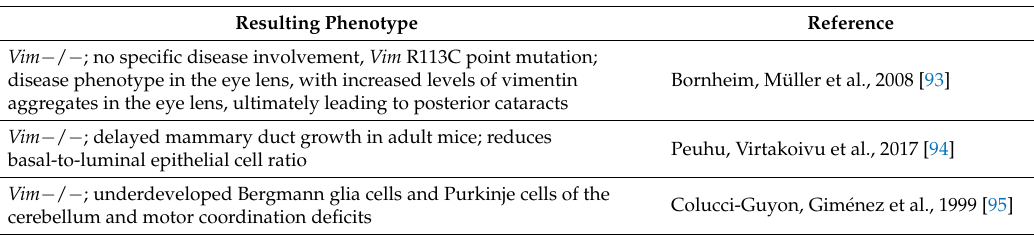
Table 1. Critical in vivo studies highlighting the effects of vimentin knockout in murine animal models, classified according to the cellular